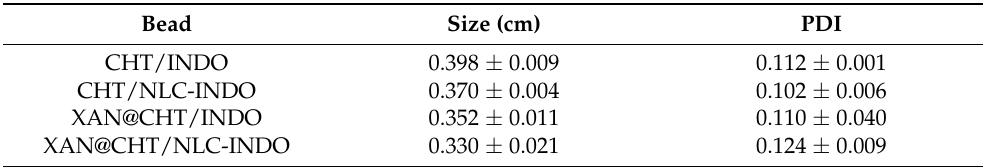
Figure 4. Digital photo ( left ) of hybrid nanobeads (XAN@CHT/NLC-INDO) and particle size distribution ( right ), estimated by ImageJ software, ( n = 3). Table 4. Frequency of size (cm) and distribution (PDI) of the prepared beads and nanobeads, obtained from digital photos and calculated by ImageJ software, n =